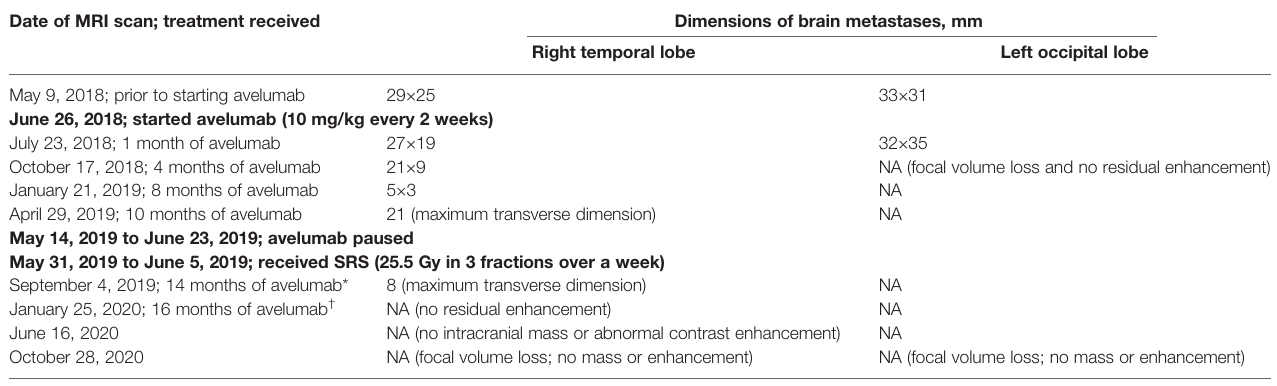
TABLE 2 | Timeline of treatments received and brain metastases size in patient case